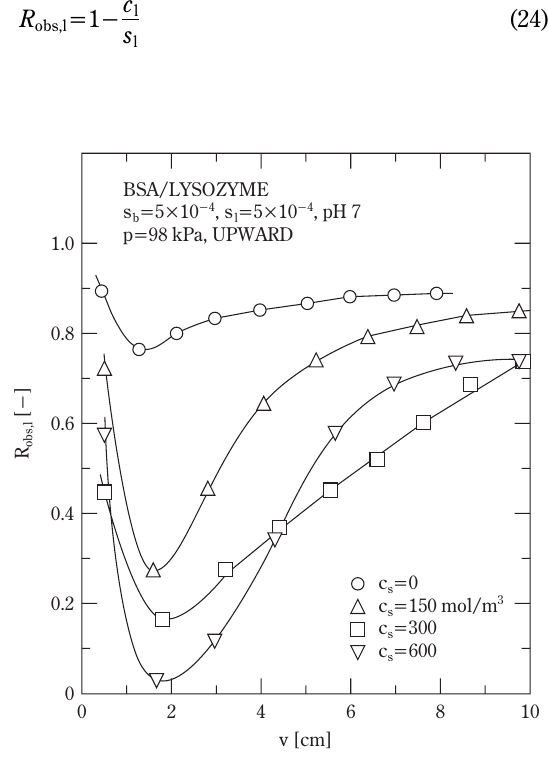
Fig. 23 Effect of salt addition on apparent lysozyme rejection at pH